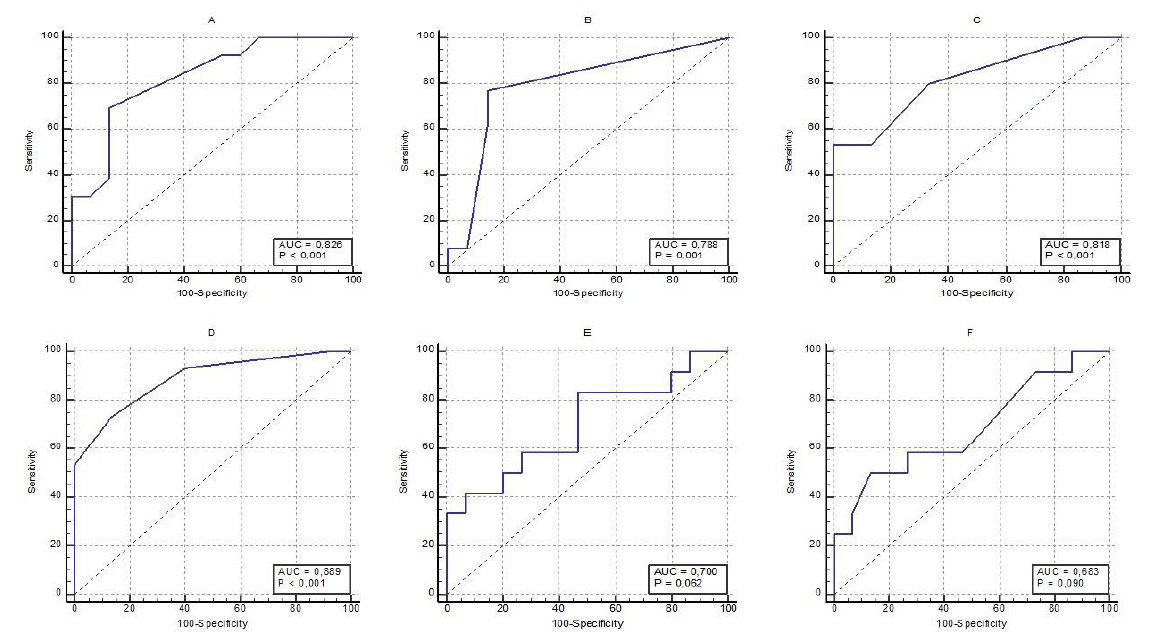
Figure 1. ROC curves: A- SNAPPE-II, B- OI, C- 1st minute APGAR score, D- 5th minute APGAR score, E- platelet, F- plateletcrit. CDH occurs during intrauterine life as a result of tho- racic displacement of abdominal organs through a defect in the diaphragm. Reported mortality rates in live-born neonates with CDH vary between 10% and 35%. [1, 22] Chronic lung problems such as bron- chopulmonary dysplasia, asthma, and recurrent lung infections are common morbidities in surviving in- fants with CDH. [3] Mortality in CDH has been asso- ciated with right-sided herniation, prenatal diagnosis, low 5-minute APGAR score, concomitant cardiac anomaly, chromosomal anomaly, and prematurity. [3, 5, 23] The non-surviving patients in our study had lower 5-minute APGAR scores than the surviving group, and five of them were not diagnosed antenatal-